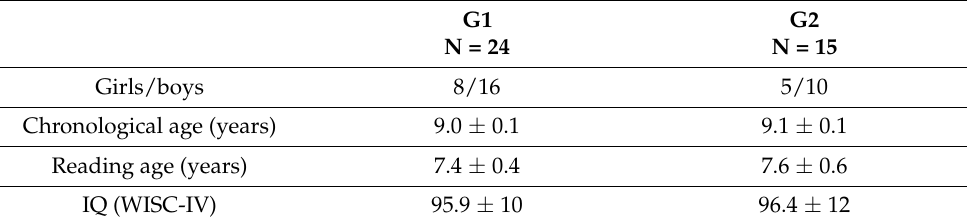
Table 1. Clinical characteristics of the two groups (G1 and G2) of children with dyslexia enrolled in the study, with the number of girls and boys, the mean and the standard deviations of the Chronological Age, the Reading Age (E.L.FE Test), and the IQ Score.